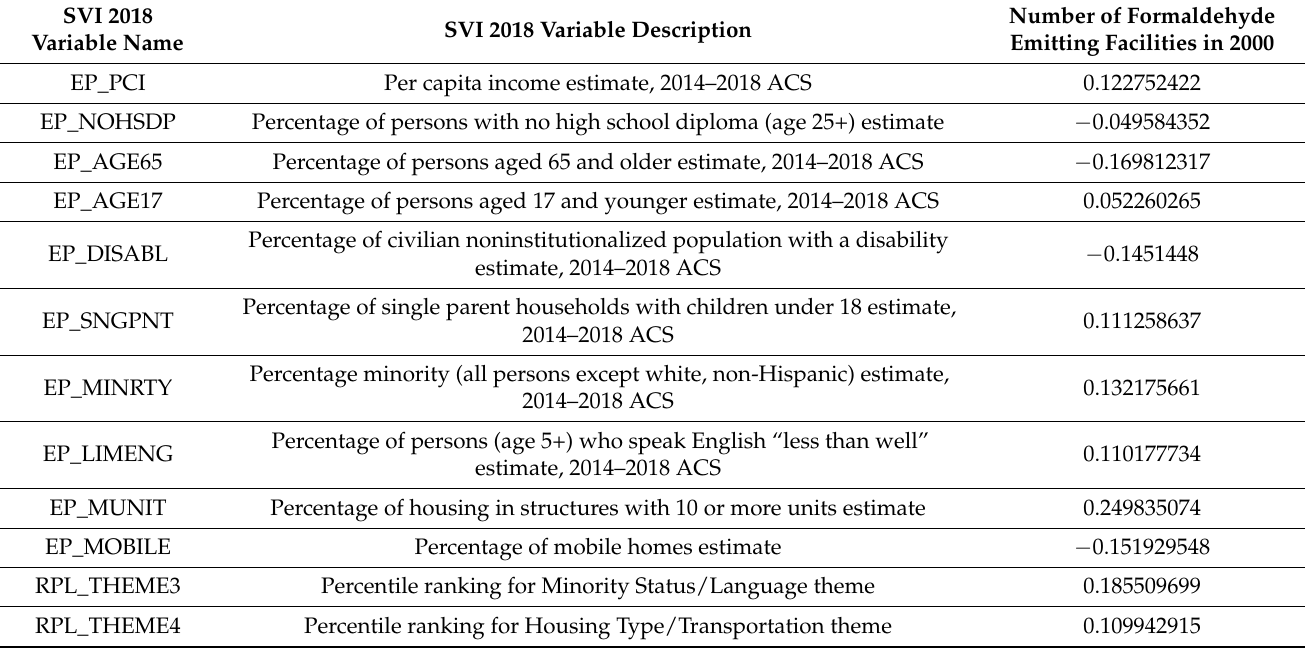
Table 2. Pearson correlations between formaldehyde-emitting facilities and Social Vulnerability Index (SVI) variables with p values <